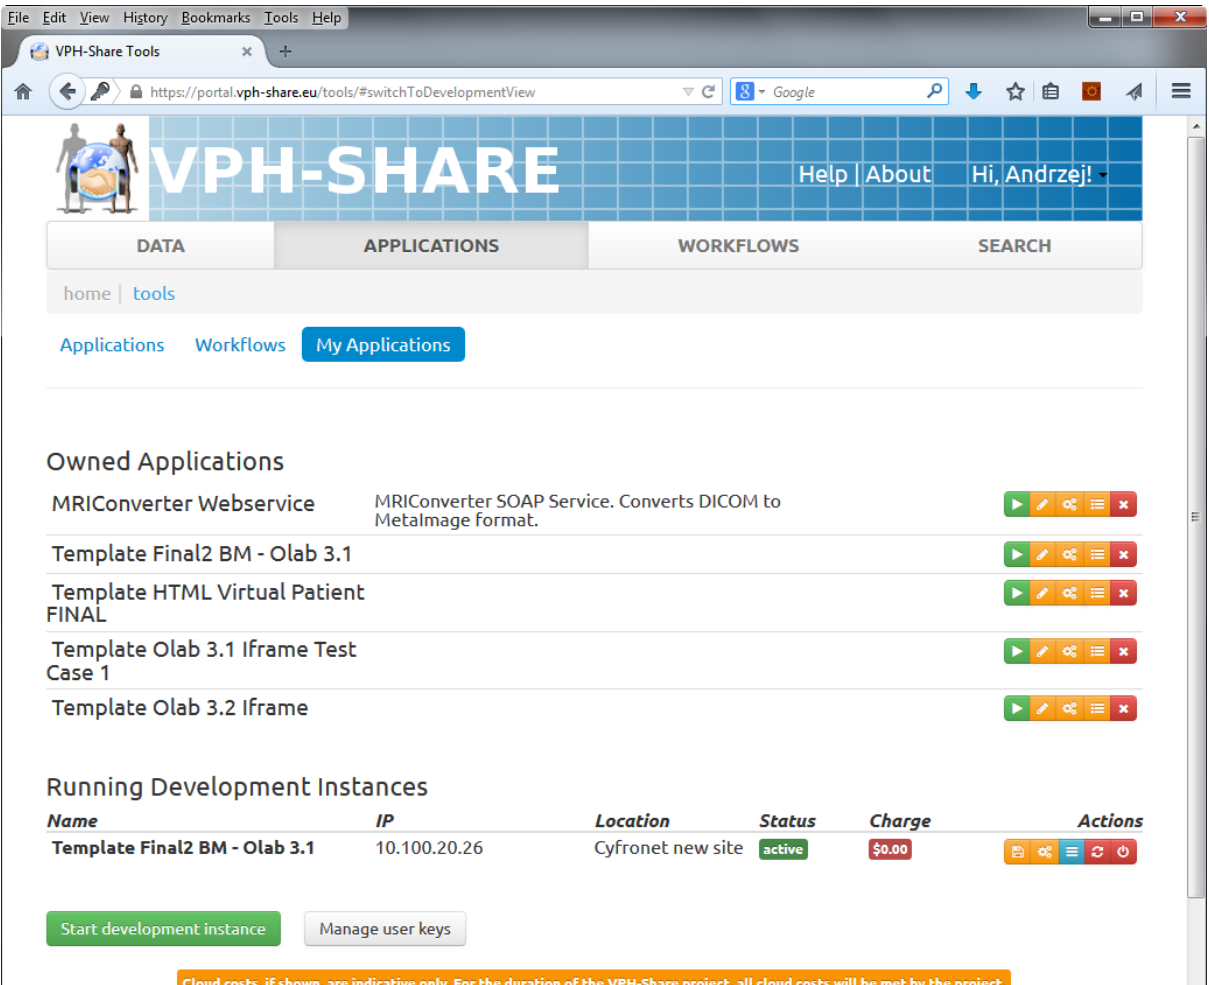
Figure 2. VPH Share cloud platform with virtual patient system templates prepared for the Behavioral Medicine MOOC and a running instance of one of the templates on a virtual